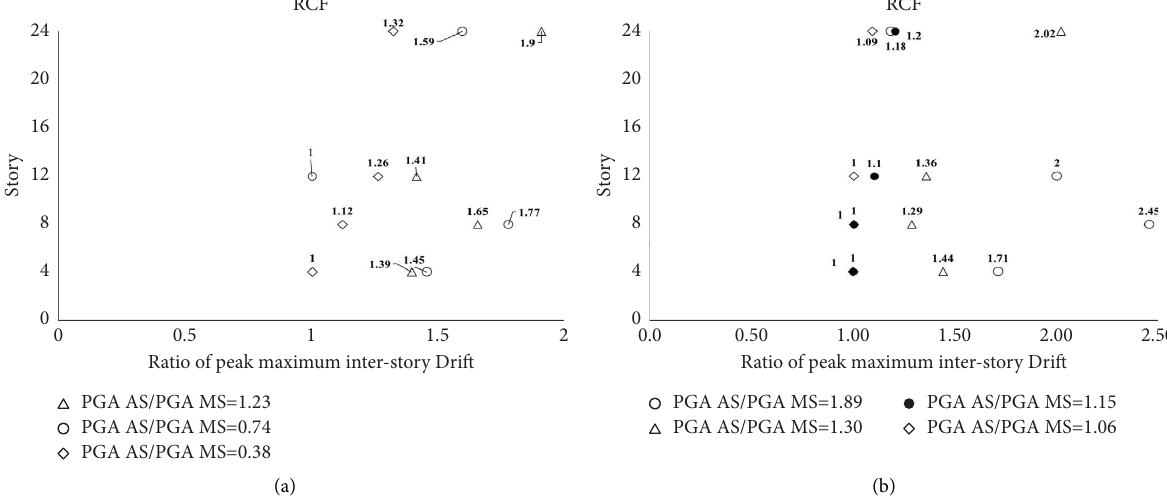
Figure 19: Ratio of the peak maximum interstory drift demand of the real SS of the models to the MS demands under in RCF with SPSW: (a) groups I and II, (b) group